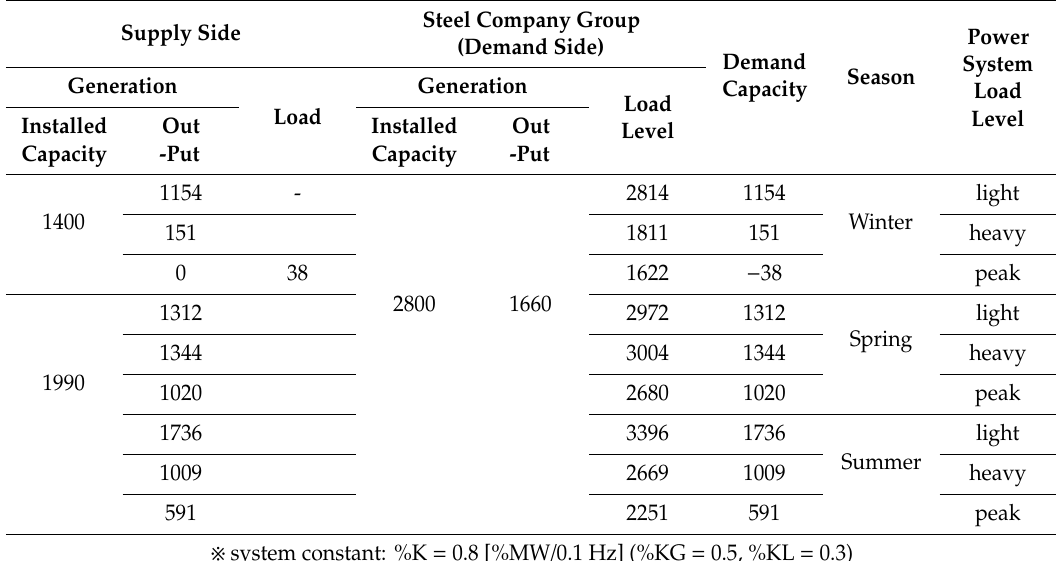
Table 8. Simulation data of the group of steel companies.